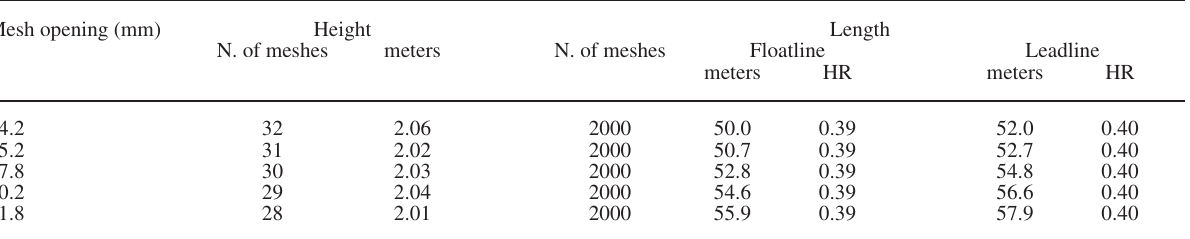
Table 1. – Technical features of the experimental sole gill nets. HR = Hanging Ratio.